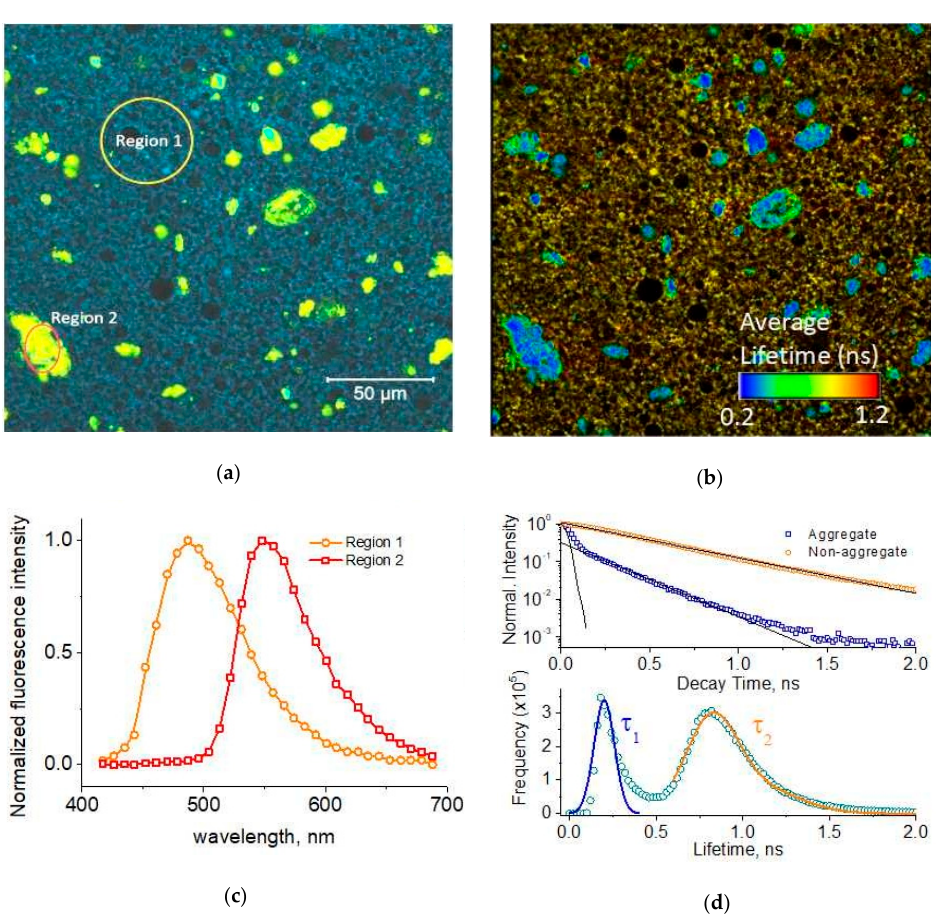
Figure 2. Spectral fluorescence image of cream ( a ) and corresponding fluorescence lifetime imaging microscopy (FLIM) image ( b ). Fluorescence spectra of regions 1 and 2 from ( a ) ( c ). Fluorescence decays and average fluorescence lifetimes distribution for the same regions ( d ).